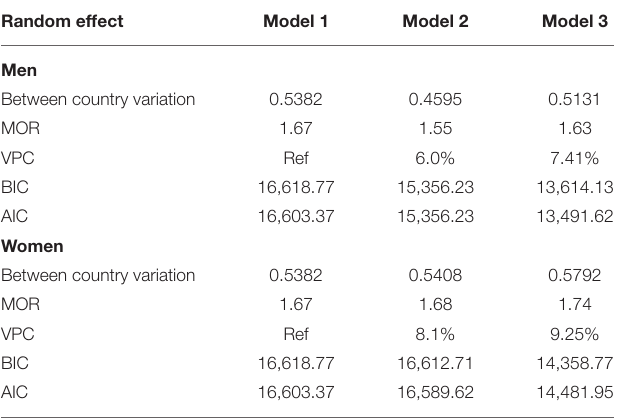
TABLE 4 | Between country variation of paid work hours and SAH by